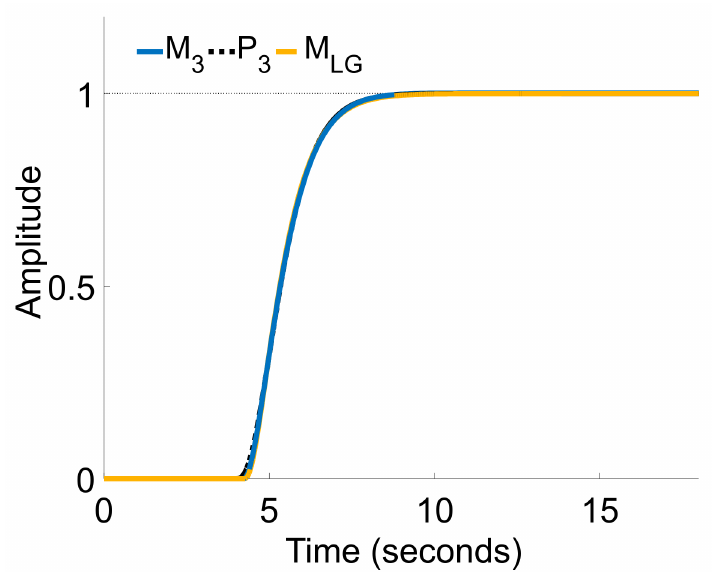
Figure 16. The unit step responses of process P 3 ( s ), model M 3 ( s ), and model M LG ( s